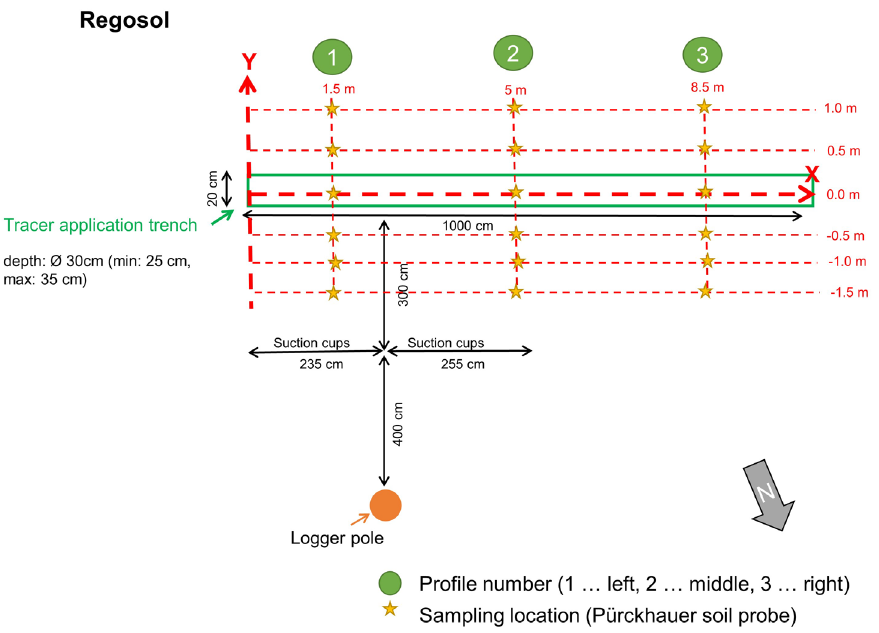
Figure A2. Location of the tracer application trench and soil sampling locations in reference to the suction cup profile of the Regosol. Table A1. Water content θ [g g − 1 ], bulk density ρ b [g cm − 3 ], effective porosity PV [-] and relative saturation S e [-] of the regosol and the luvisol along the tracer application trench during the tracer application on October 08 and 09, 2019.